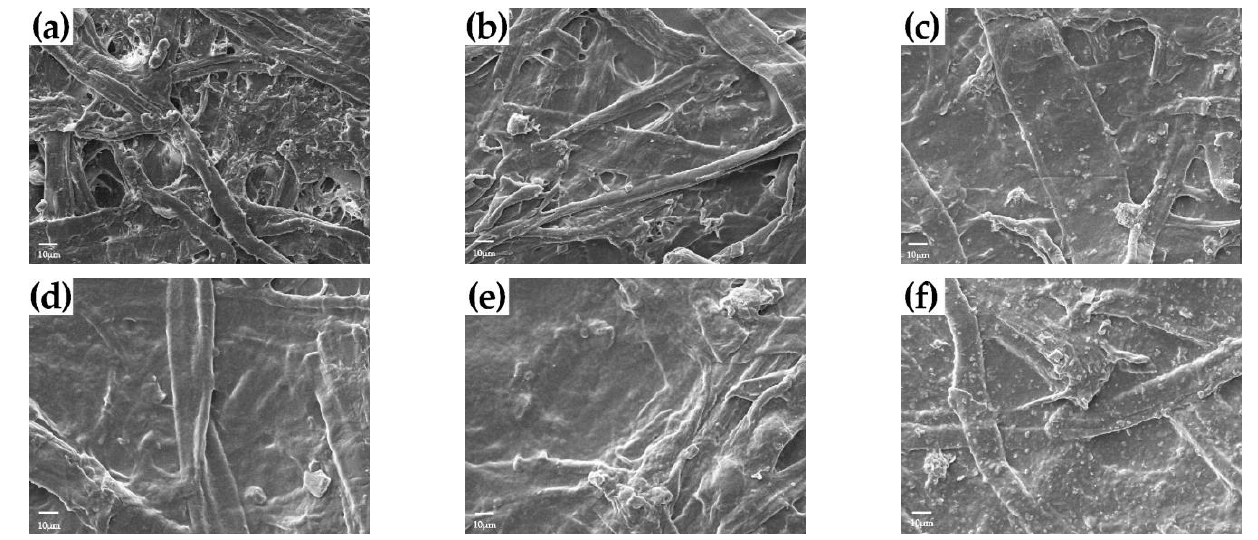
Figure 3. SEM images of the uncoated paper Un ( a ), C2 ( b ), C2M0.1 ( c ), C2.5 ( d ), C3 ( e ), and C2M0.3 ( f ).